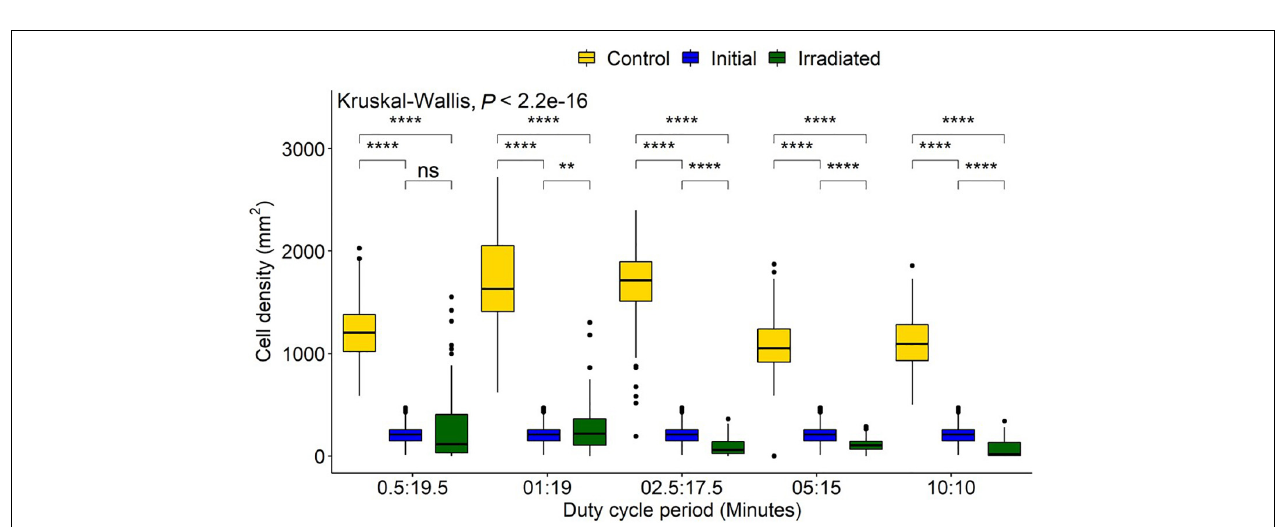
FIGURE 5 | Navicula incerta abundance after UV irradiance over varying periods with respective fluences. Durations of 2 h, 1, 2, 3, 4, and 5 days produced fluences of 0.78, 9.35, 18.70, 28.05, 37.40, and 46.75 J/cm 2 , respectively.